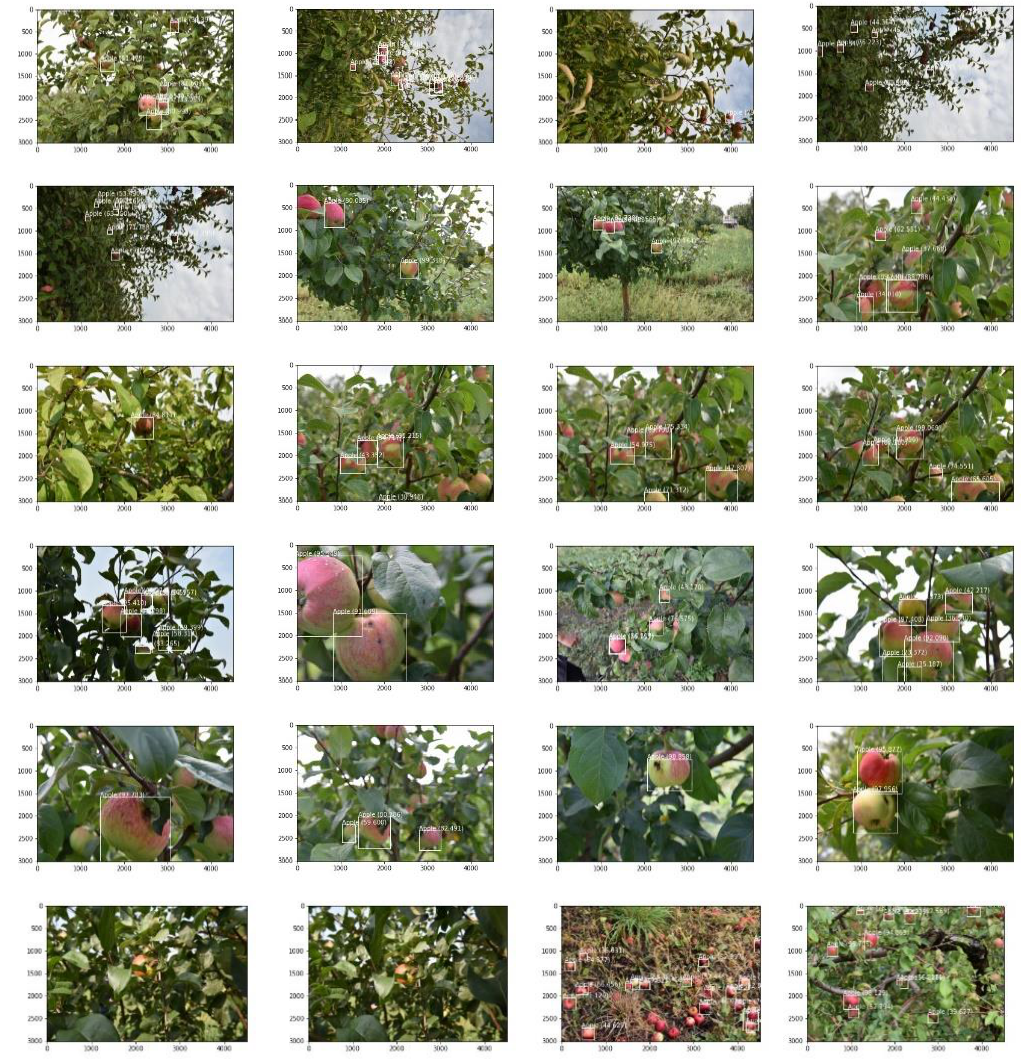
Figure 7. Examples of red apple detection.